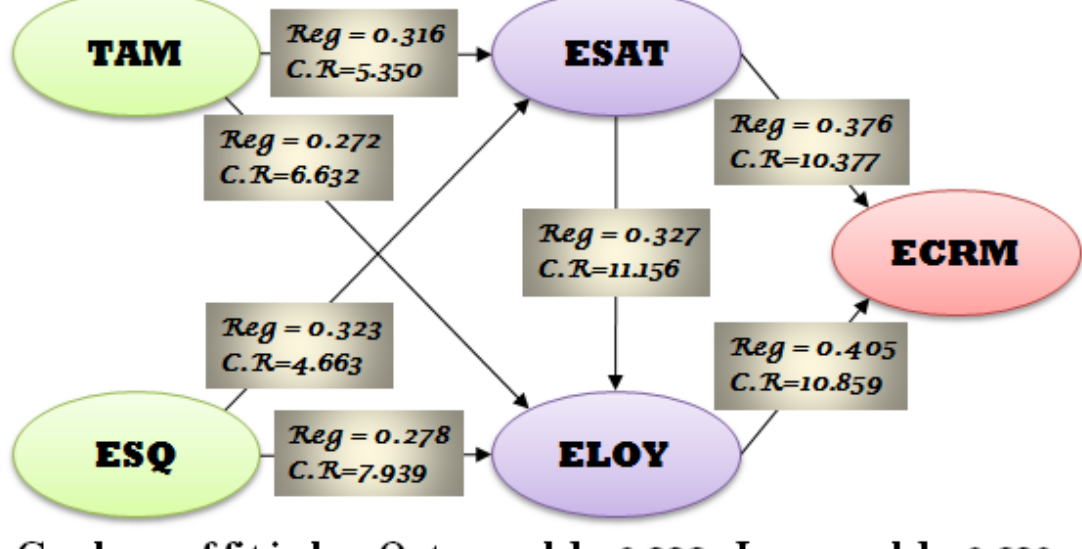
Fig. 2. The results of exogenous and endogenous variables